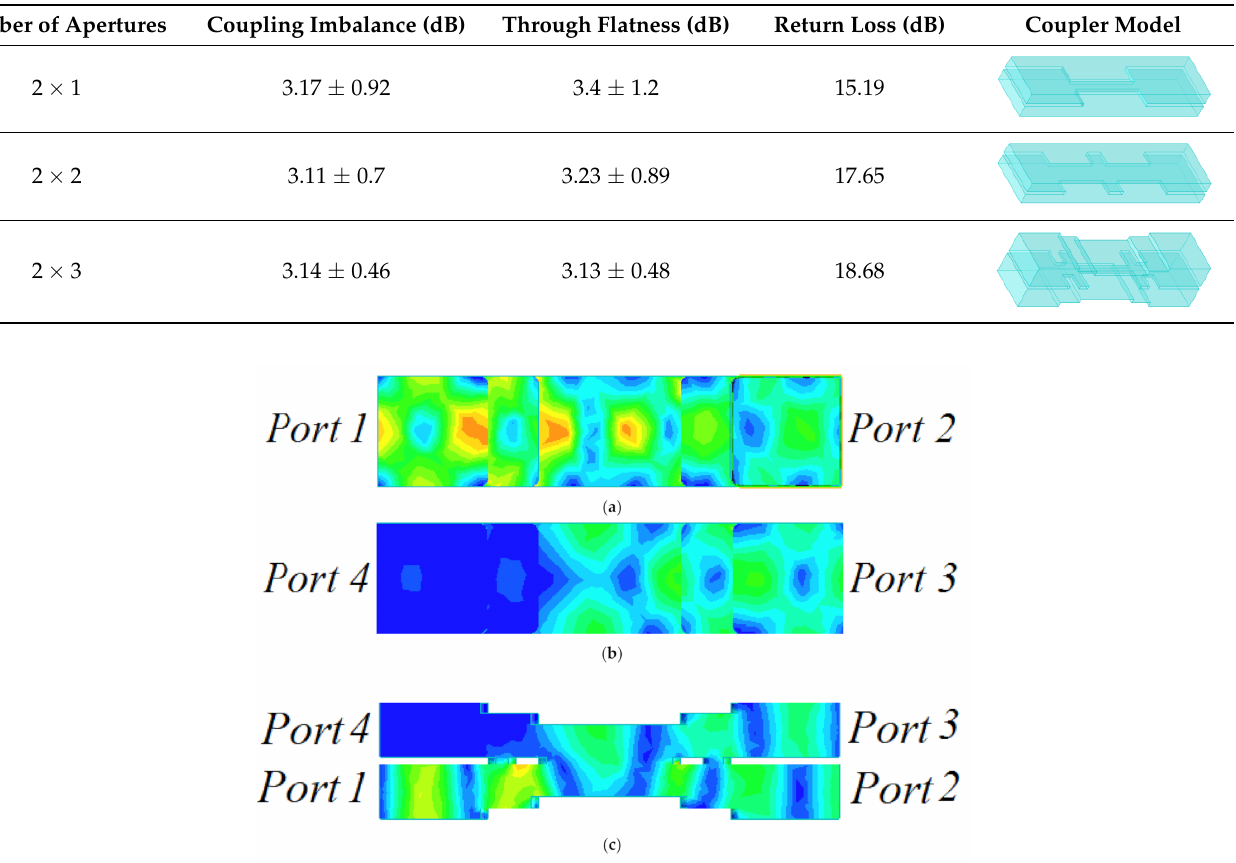
Table 2. Performance of 3 dB directional coupler with different number of large apertures.